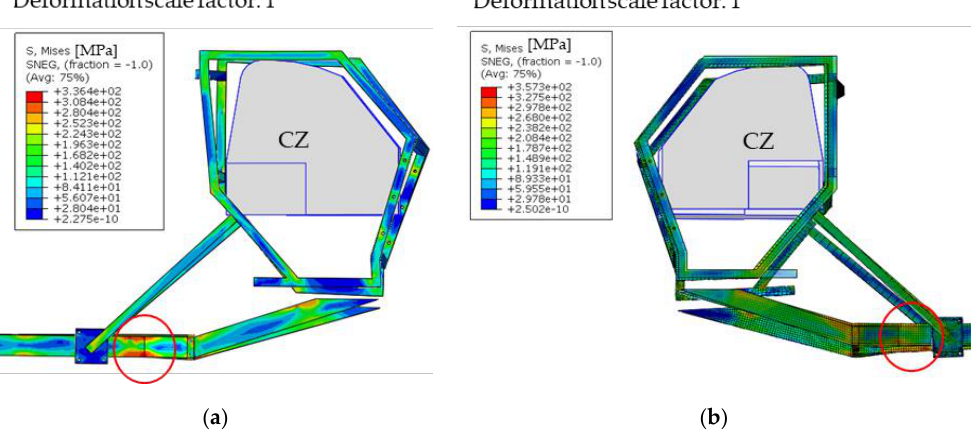
Figure 7 . Crushing effects attained at the maximum required load, lateral view of ROPS and clearance zone: ( a ) contour plot of Von Mises stress, first crushing, without undeformed shape superimposition (expressed in MPa); ( b ) contour plot of Von Mises stress second crushing (expressed in MPa).